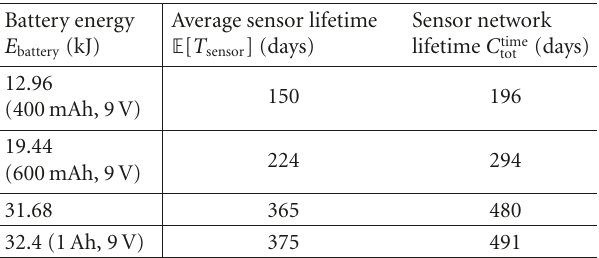
Table 2: Sensor network lifetime for a realistic ZigBee wireless sen- sor network in a scenario with N = 64 sensors, P t = 1mW, and Figure 12. Di ff erent values of the battery energy at a sensor are con-